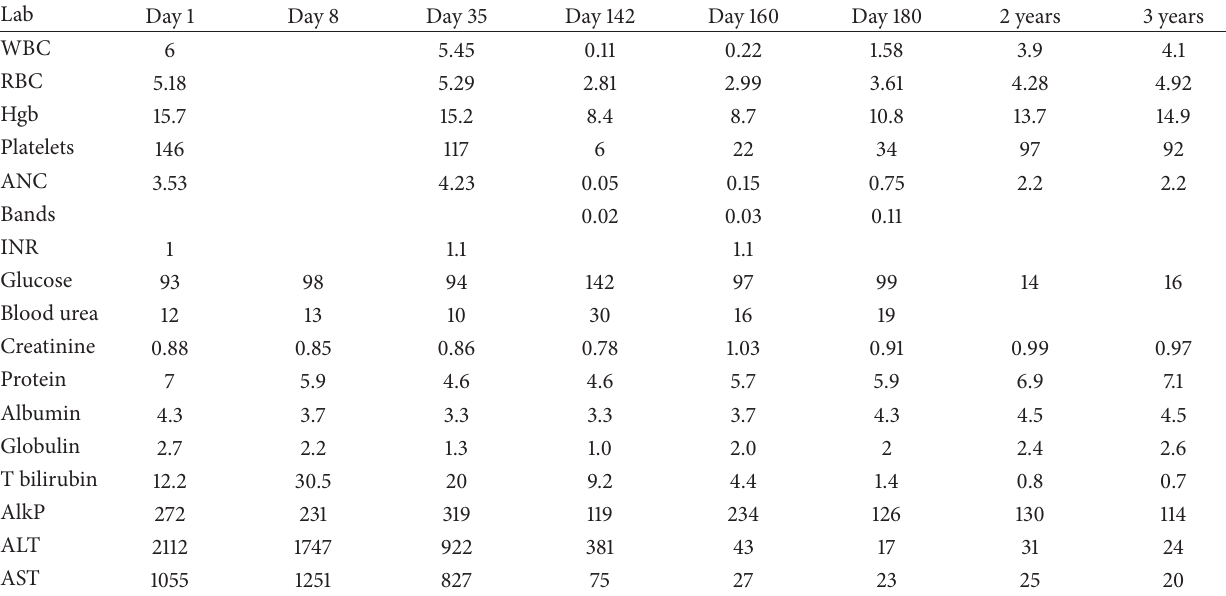
Table 1: Laboratory test flow